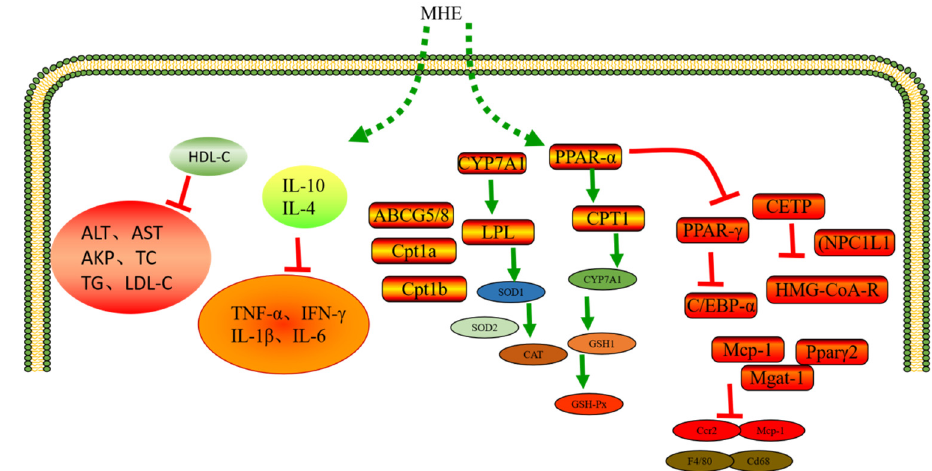
Figure 5. Hypolipidemic mechanism of MH.